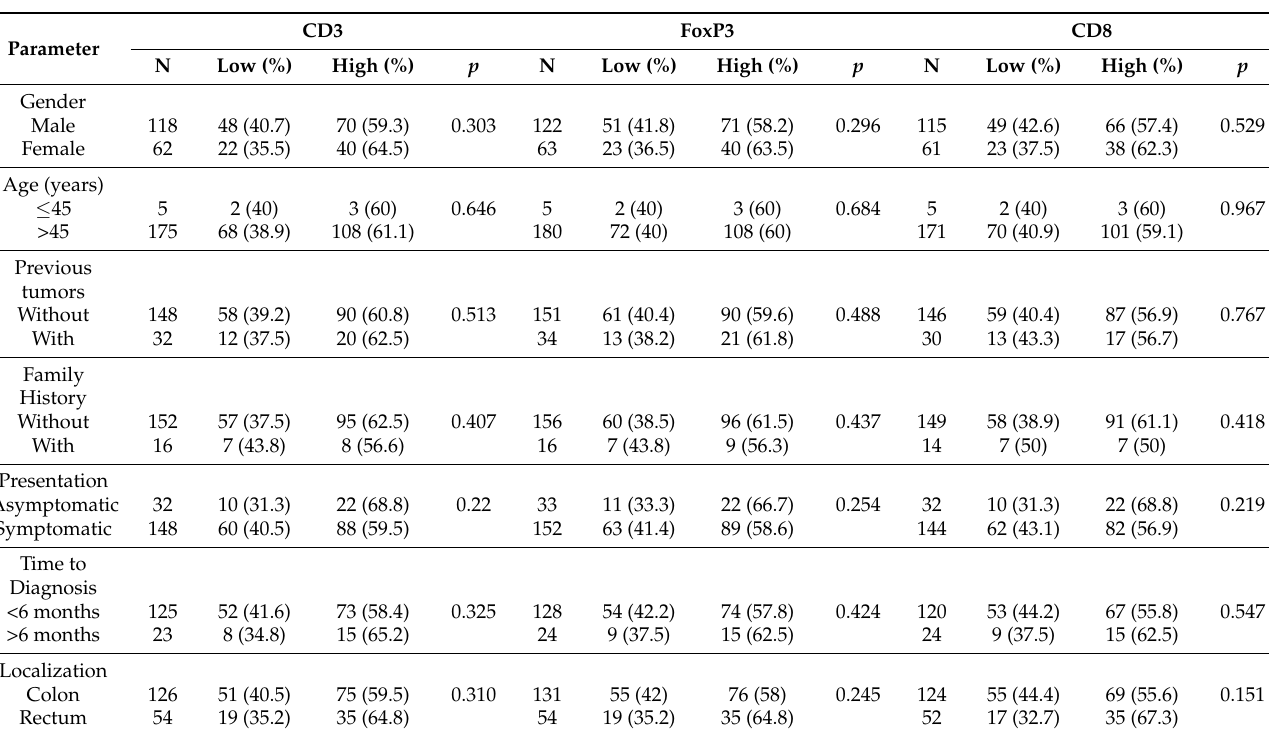
Table 6. Association of tumor margin infiltration of CD3 + , FoxP3 + , and CD8 + T lymphocytes with clinical data. Parameter